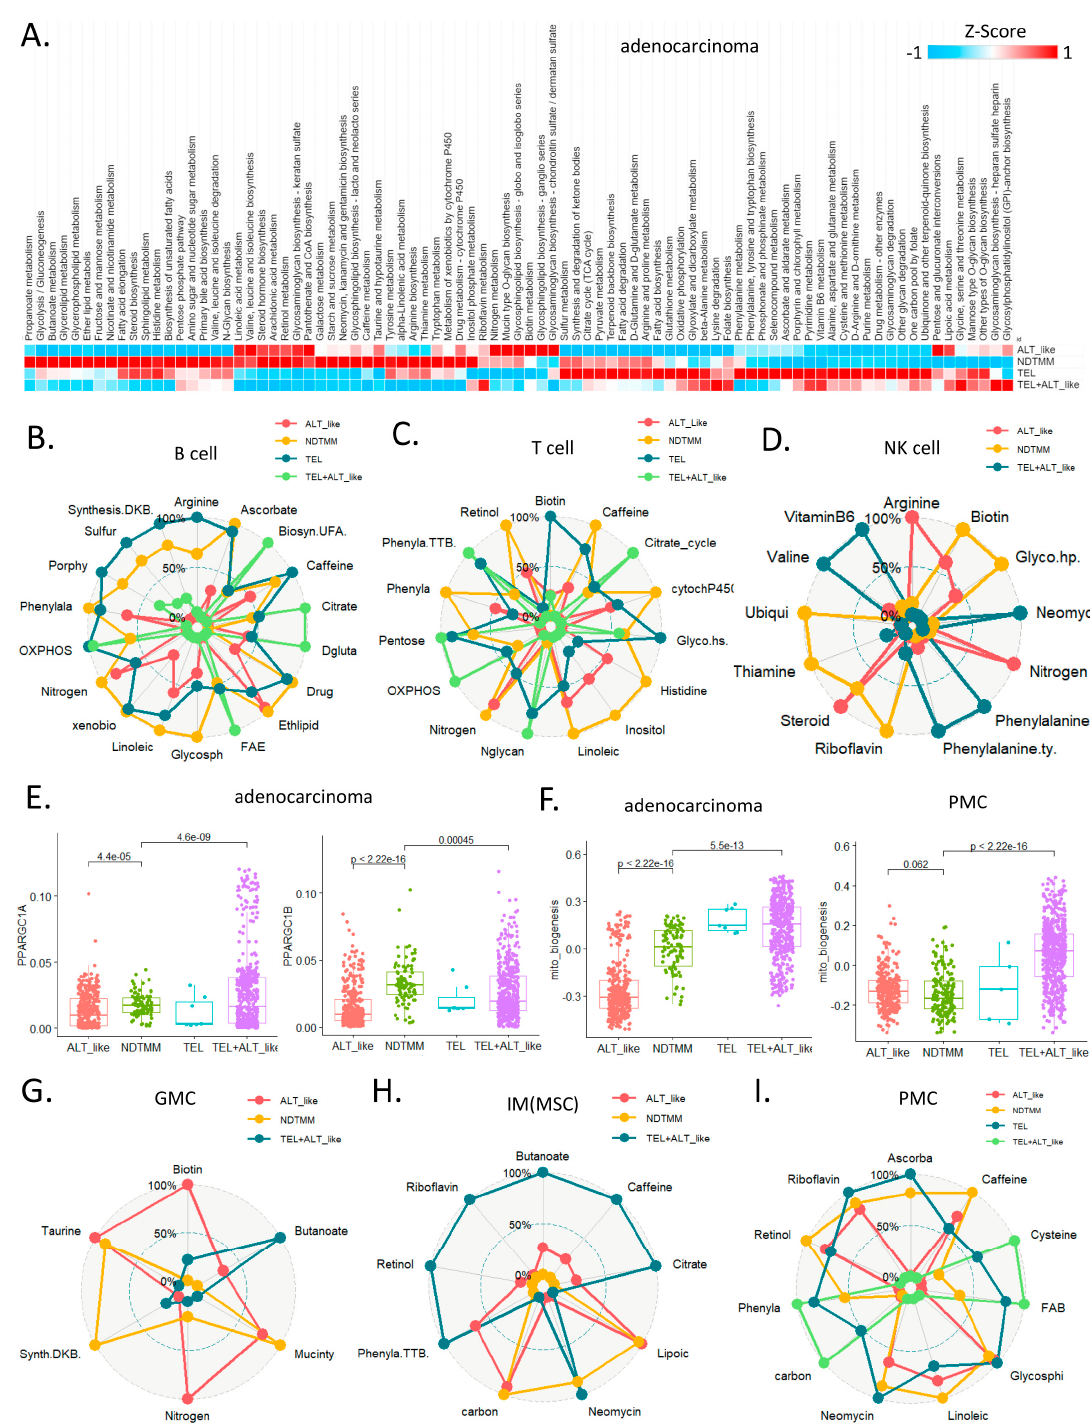
Figure 4. Landscape of metabolic reprogramming of and telomere maintenance mechanism (TMM) types. ( A ) Heatmap of metabolic reprogramming landscape of cells with four TMM types in ade- nocarcinoma. Spider plots of top enriched metabolic pathways for ( B ) B, ( C ) T, and ( D ) NK cells. ( E ) Box plot of PPARGC1A , PPARGC1B (mitochondria bioenergetics master regulators) for adenocar- cinoma cells. ( F ) Boxplot of mitochondria bioenergetics signature score for adenocarcinoma cells and PMC. Spider plots of top enriched metabolic pathways for ( G ) GMC, ( H ) intestinal metaplasia (IM), metaplasia stem cell (MSC), and ( I )